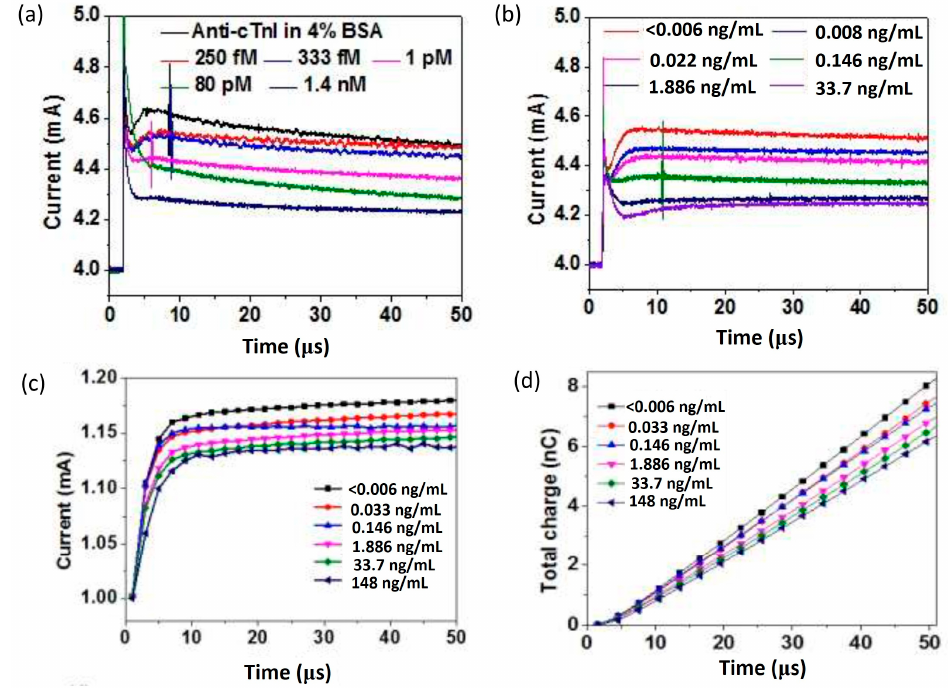
Figure 10. Current versus time graph of ( a ) purified proteins prepared in 1 X PBS containing 4% BSA and ( b ) clinical human serum samples for the antibody-based detection of Troponin I. ( c ) Current versus time and ( d ) total charge versus time graph for the aptamer-based detection of Troponin I in clinical human serum samples. Reprinted from [120], Copyright 2018, with permission from Elsevier .